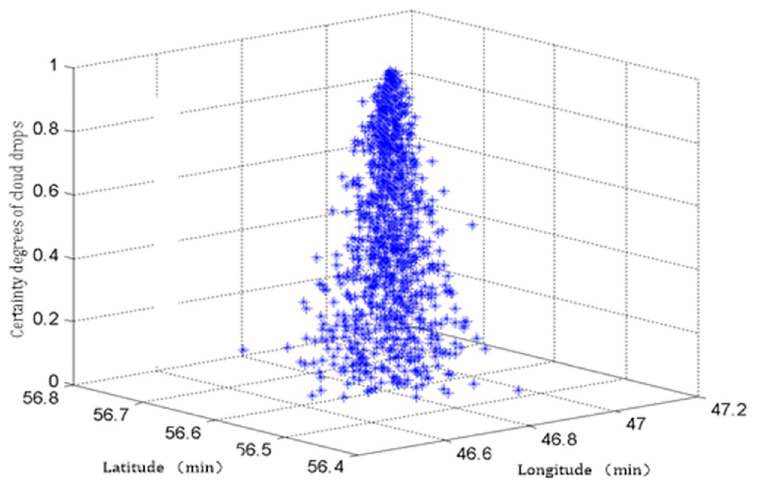
Fig 6. The normal cloud diagram of sampling point No.14.